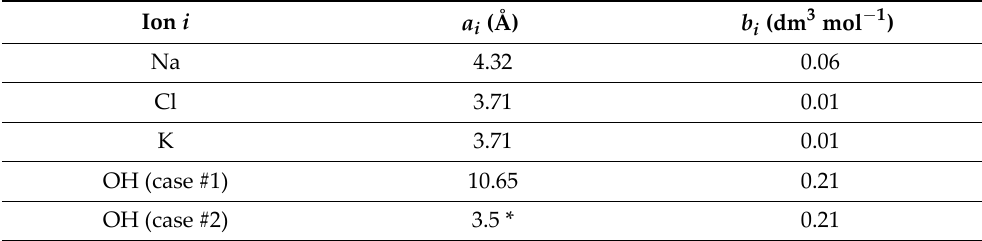
Table 4. The parameters of the Truesdell–Jones model (see (11)) used in this work (based on